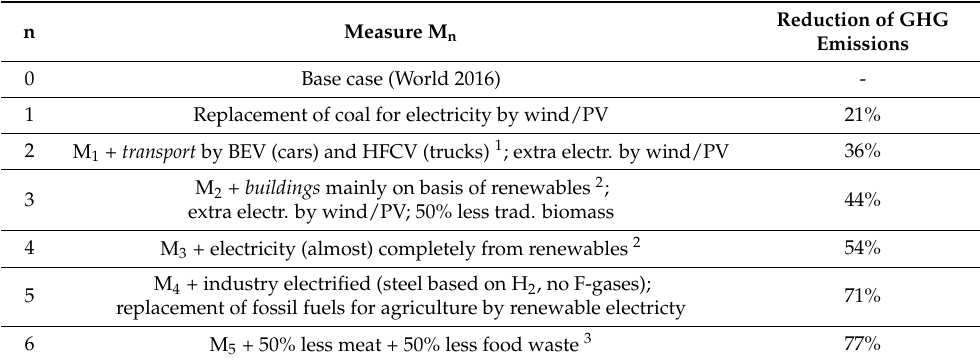
Table 7. Consecutive measures considered in this work to reduce global GHG emission and respective reduction of GHG emissions. The global population and the average prosperity (heat demand, use of different modes of transportation, industrial production of materials and goods) are here (simplifying) considered as